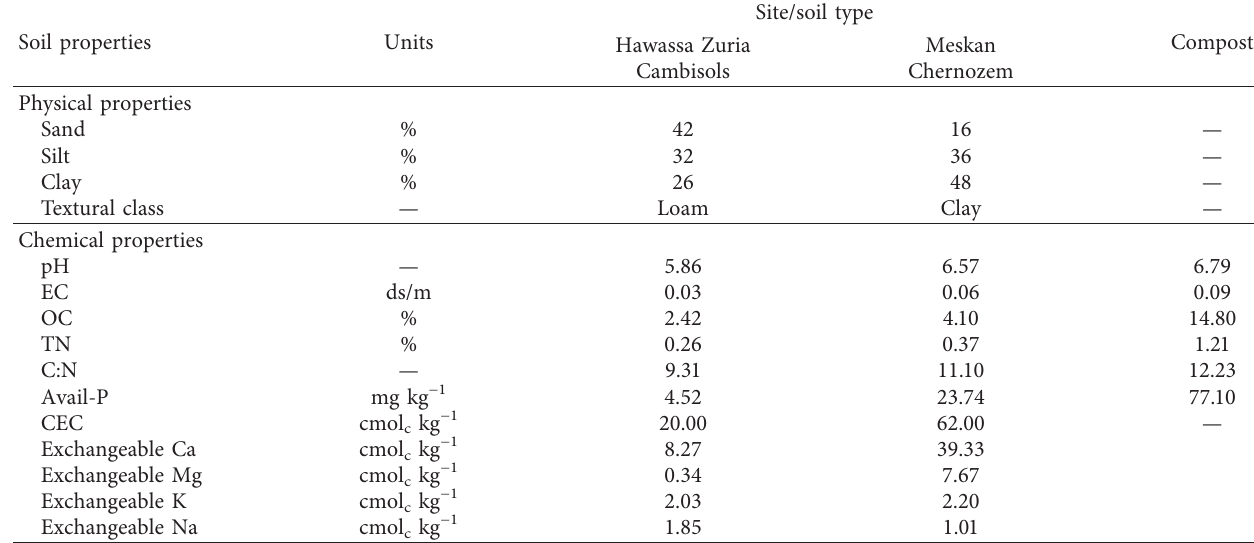
Table 1: Some physicochemical properties of the surface layer of soils (0–20cm) and compost prior to treatment